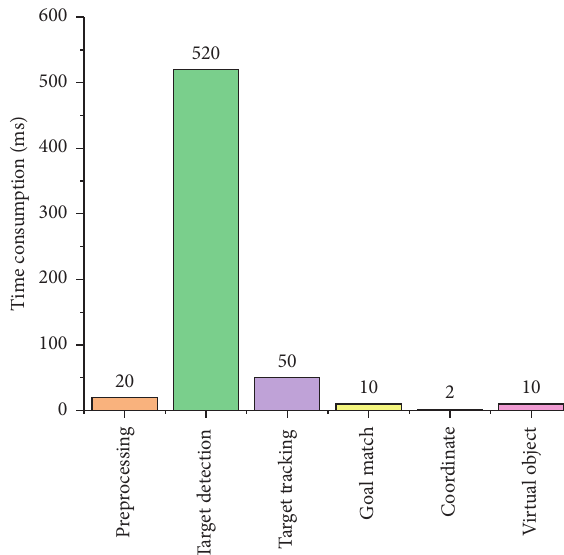
Figure 13: Statistical results of average time-consuming system